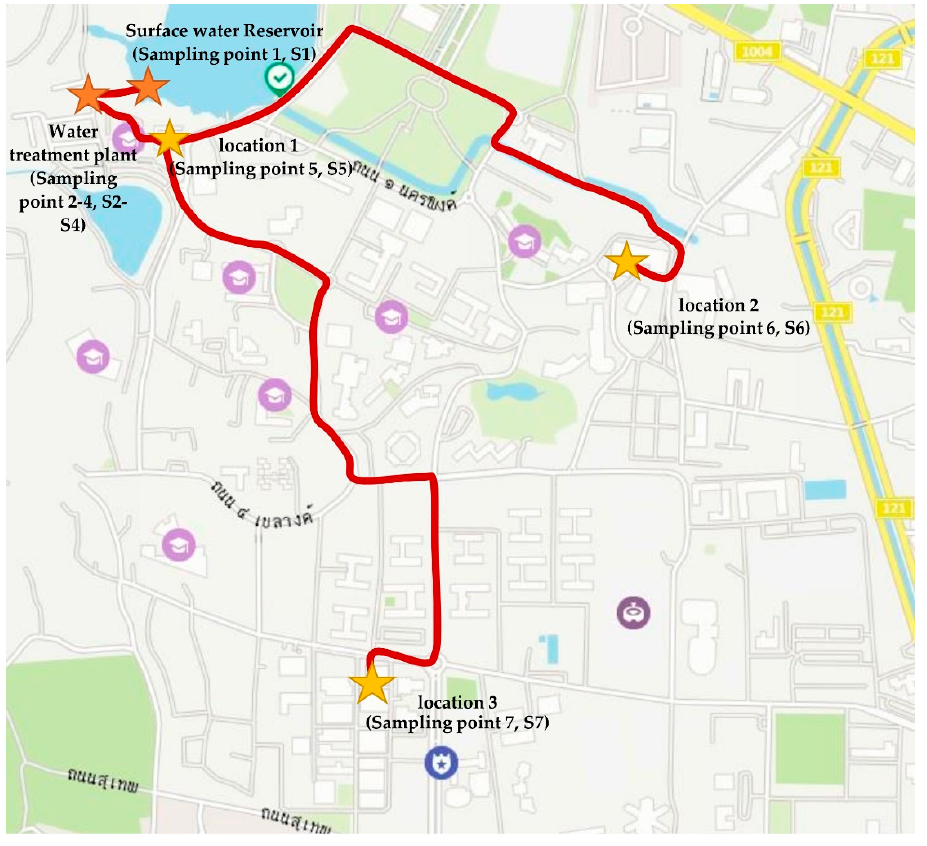
Figure 1. Sampling locations [26].